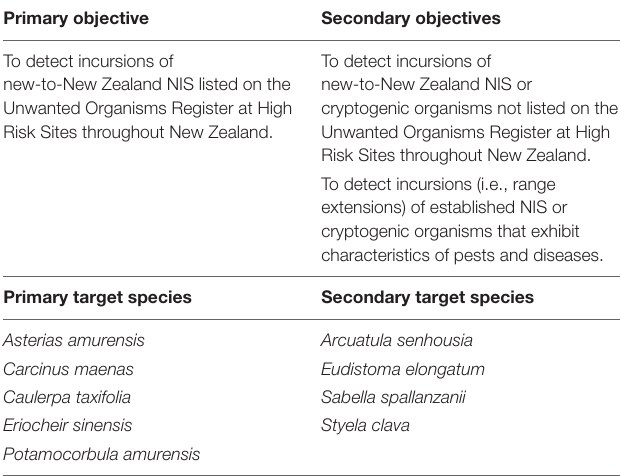
TABLE 2 | Objectives and target species for MPI’s MHRSS program. Primary